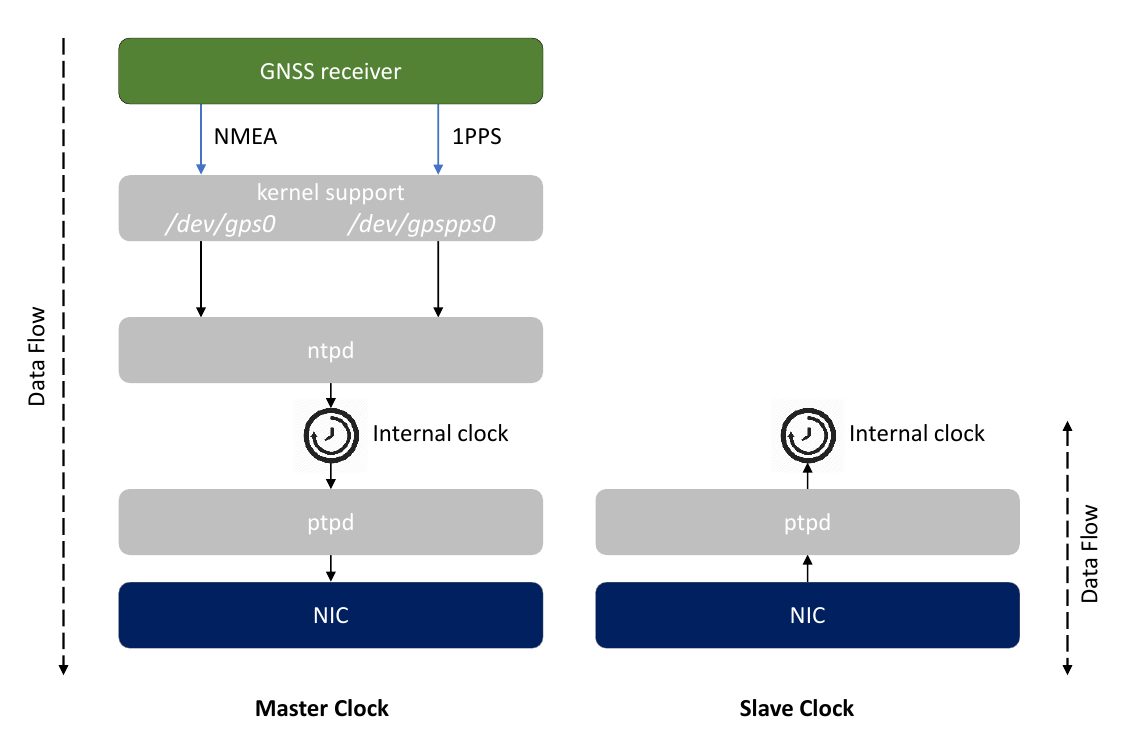
Figure 4. Software stack and configurations for Master Clock and Slave Clock